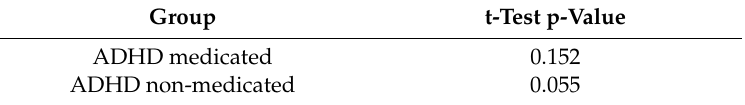
Table 4. p-Values for the analysis of each ADHD group compared with the control